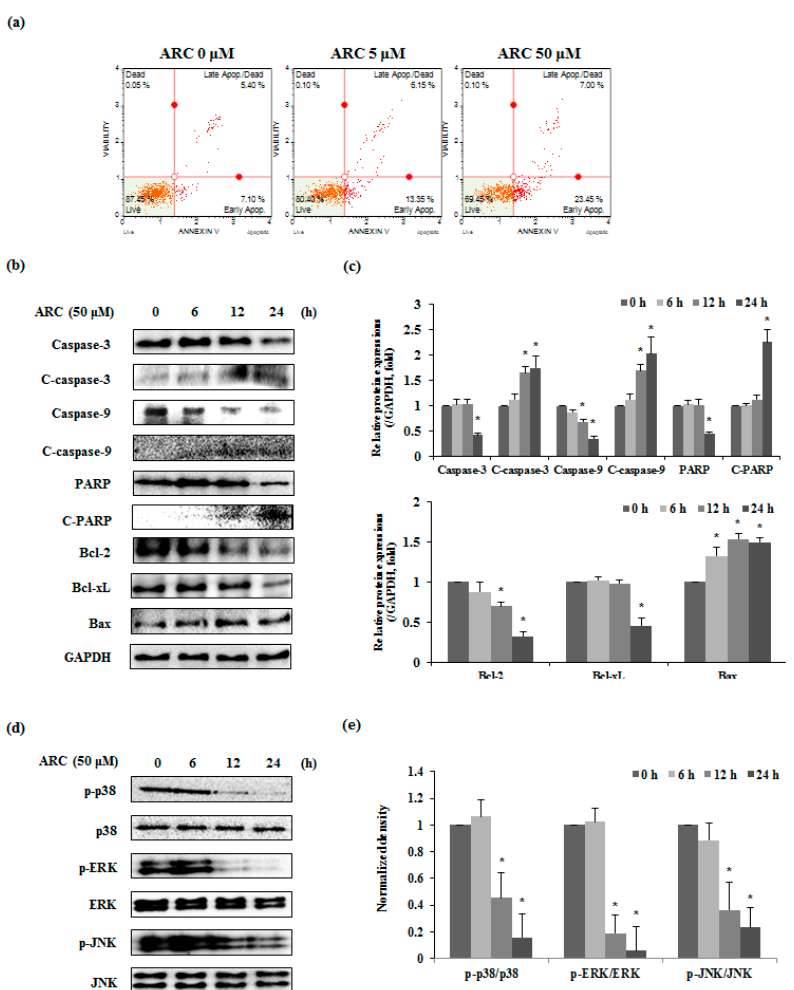
Figure 3. ARC induces cell death via apoptosis. ( a ) CT26 cells were incubated with the indicated concentrations of ARC for 48 h and stained with Annexin V and PI; ( b , c ) CT26 cells were treated with ARC for 0–24 h and confirmed by Western blotting for caspase-3, -9, PARP, Bcl-2, Bcl-xL, and Bax, respectively. The band intensities were measured by densitometry and presented as the relative ratio to GAPDH; ( d , e ) CT26 cells were treated with ARC (50 μ M) for 0–24 h and phosphorylation of p38, ERK, and JNK were detected by Western blotting. The band intensities were measured by densitometry and presented as the relative ratio. Results are expressed as the mean ± SD. * p < 0.05.